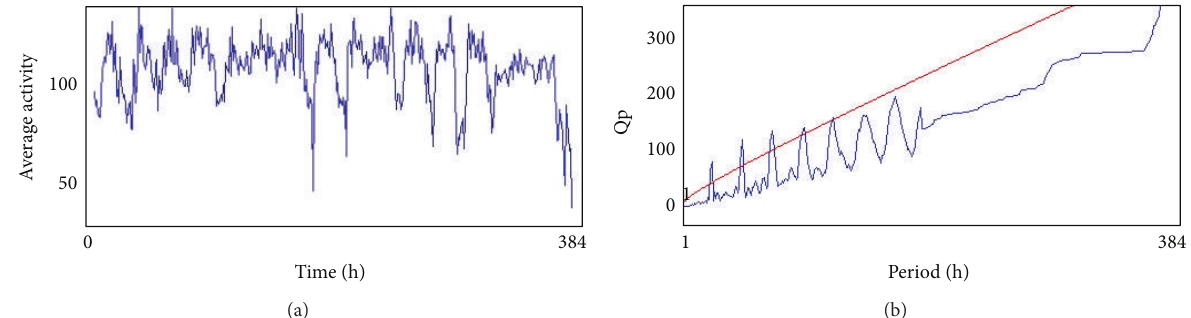
Figure 13: (a) and (b) show the average activity pattern and chi-square periodogram, respectively, for the control flies exposed to 1.0 𝜇 L/mL of Centella asiatica leaf extract in diet ( 𝑁 = 20 ).